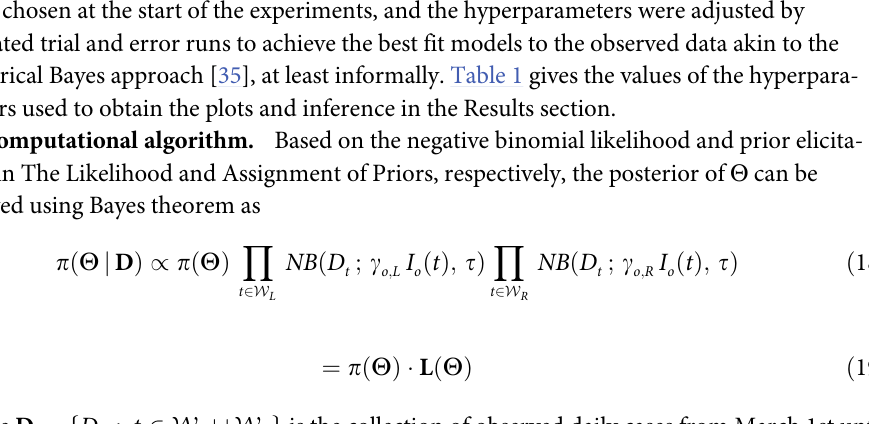
D . The midpoint m is determined similarly as before using the value of the second deriva- e 0 e 0 tive of the fitted polynomial evaluated at time t = 0 and the generated value of δ . The half- width D > 0 is once again fixed to be large to represent the maximum extent of prior uncer- e 0 tainty around m . e 0